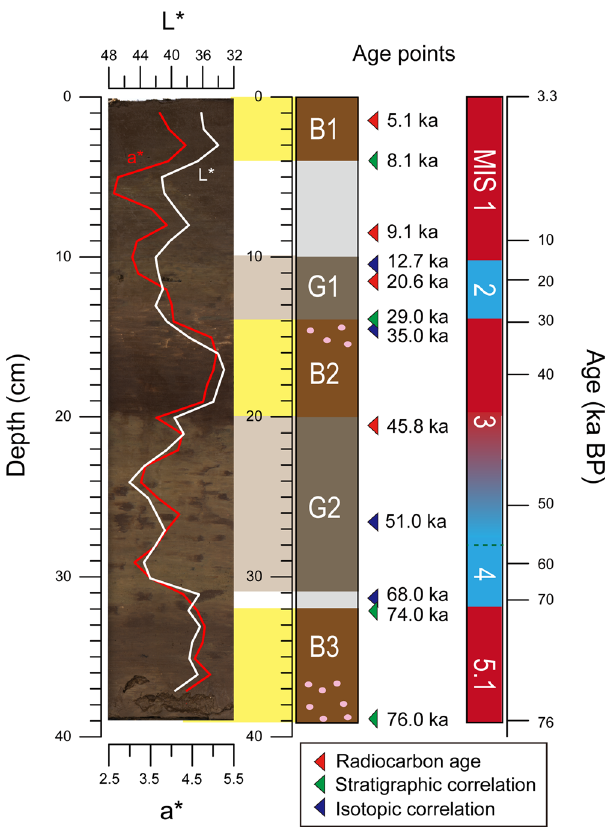
Fig. 5 Revised lithostratigraphy and age models. Depth intervals for lithostratigrapphic Units G1, B2, and G2 were adjusted primarily based on colour re fl ectance L* values and radiocarbon ages. The age model was applied based on the previous construction using radiocarbon ages and by correlating lithostratigraphy and stable isotopes of planktic foraminifers with neighbouring cores 15 . The age for core-top sediments was estimated by linear